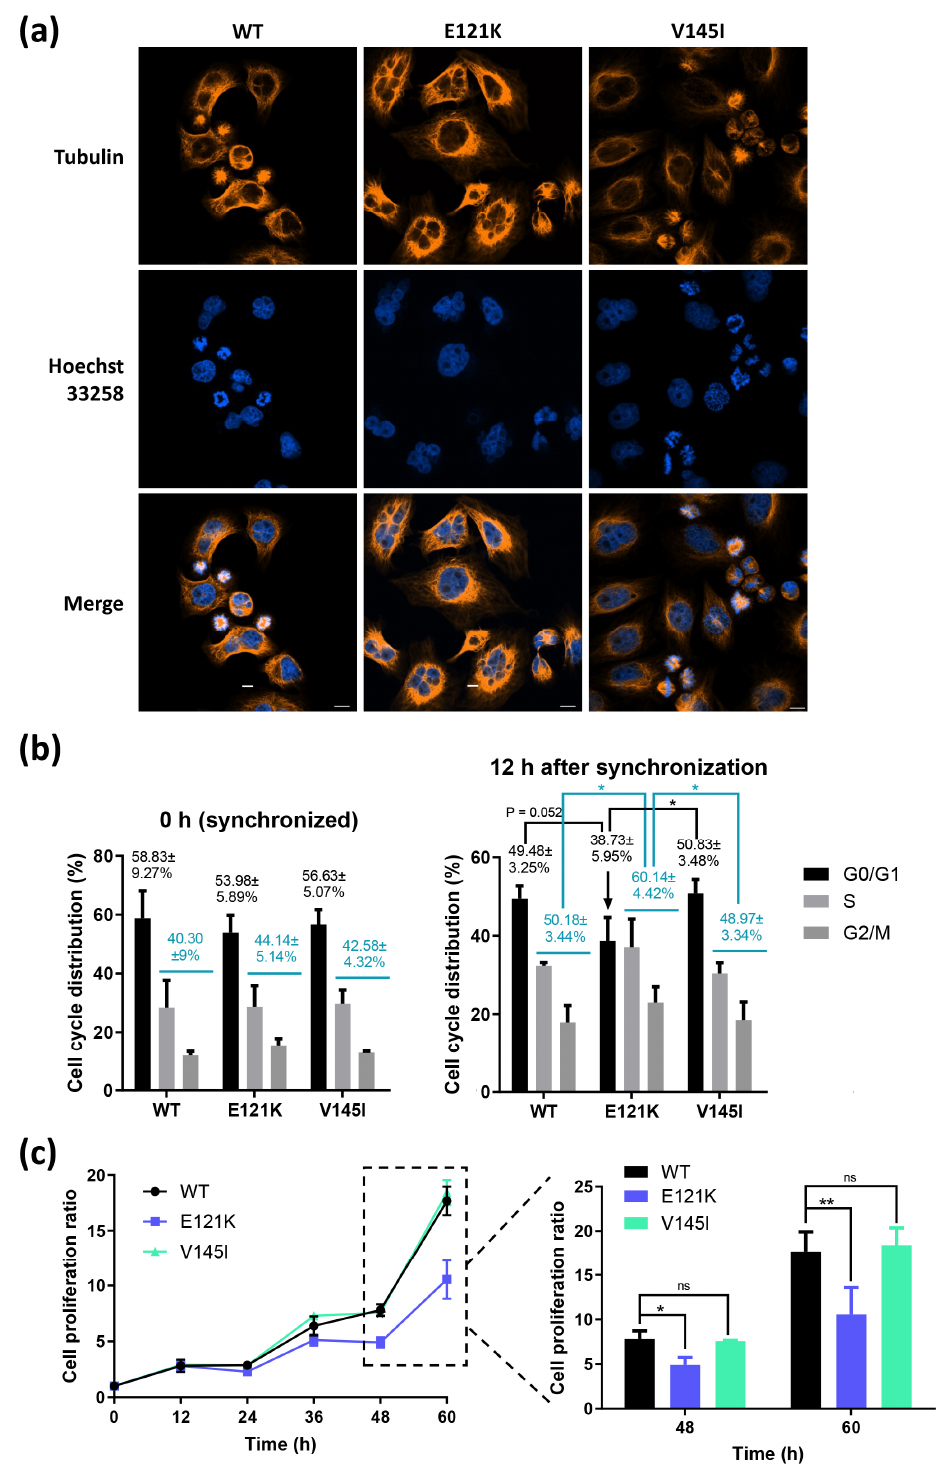
Figure 4. Effects of coilin SNP variants on cell growth-related phenotypes. ( a ) Microtubule regrowth assay: coilin WT and SNP variant cells were treated with nocodazole for 16 h, and stained with tubulin antibody after 1 h to visualize microtubules upon regrowth; scale bar = 10 µm ( b ) Cell cycle distribution was measured by the flow cytometry: cells were starved in FBS-free culture medium for 24 h and stimulated with 10% FBS for 12 h. Numbers highlighted in blue represent the % cell distributions of S phase + G2/M phase. ( c ) Cell proliferation was determined by MTS assay in a 12 h interval for up to 60 h. * p ≤ 0.05; ** p ≤ 0.01; ns: not significant.